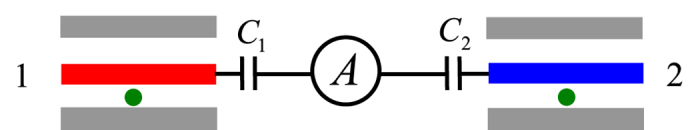
Setup of two cavities (1,2) connected by a superconducting transmon qubit A.Here, each cavity represents a one-dimensional coplanar waveguide transmission line resonator, qubit A is capacitively coupled to cavity j via a capacitance Cj (j = 1, 2). The two green dots indicate the two transmon qubits (1, 2) embedded in the two cavities, respectively. The interaction of qubits (1, 2) with their cavities is illustrated in Fig. 5(a,b), respectively. The interaction of qubit A with the two cavities is shown in Fig. 5(c). Due to three levels for each qubit considered in our analysis, each qubit is renamed as a qutrit in Fig. 5.